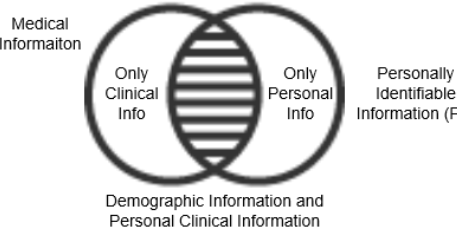
Figure 2. Relationship of personal information and medical information demographically.